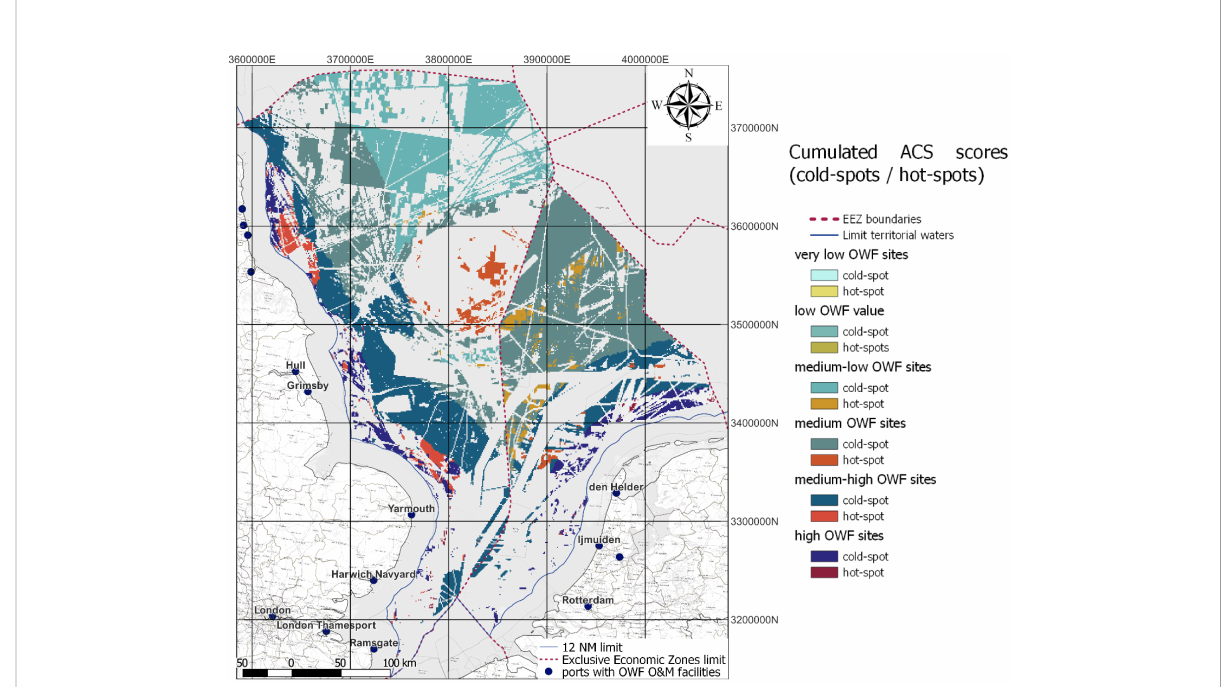
FIGURE 6 Sequence of steps to map the spatial distribution of con fl ictual areas by sea user, using the ACS